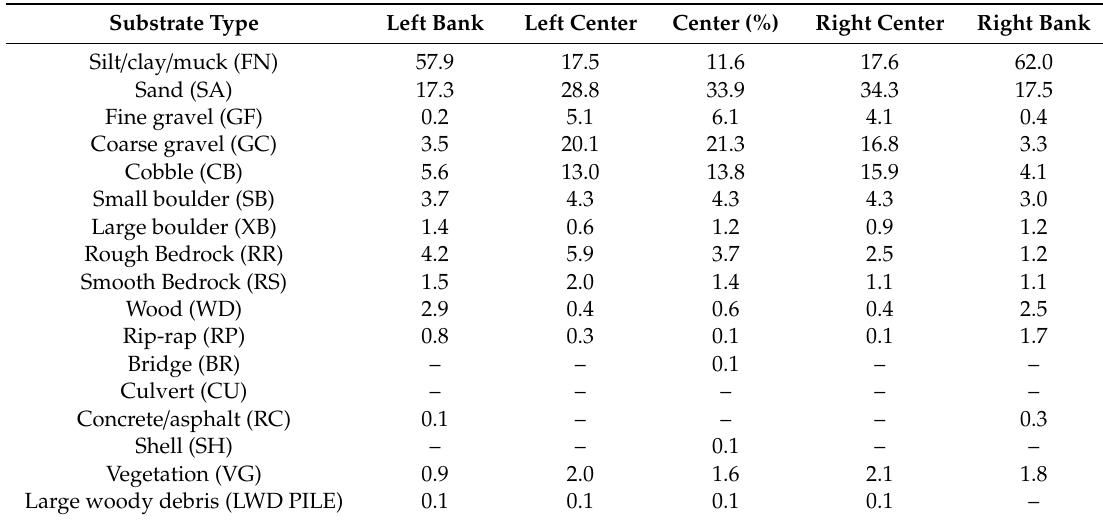
Table 4. Bank to bank variability of streambed substrate frequency in Hinkson Creek Watershed, Missouri, USA. Each datum is a percent of a substrate type observed at a bank position along the entire 56km stream length of the reference stream. Substrate definitions are presented in Table 2.